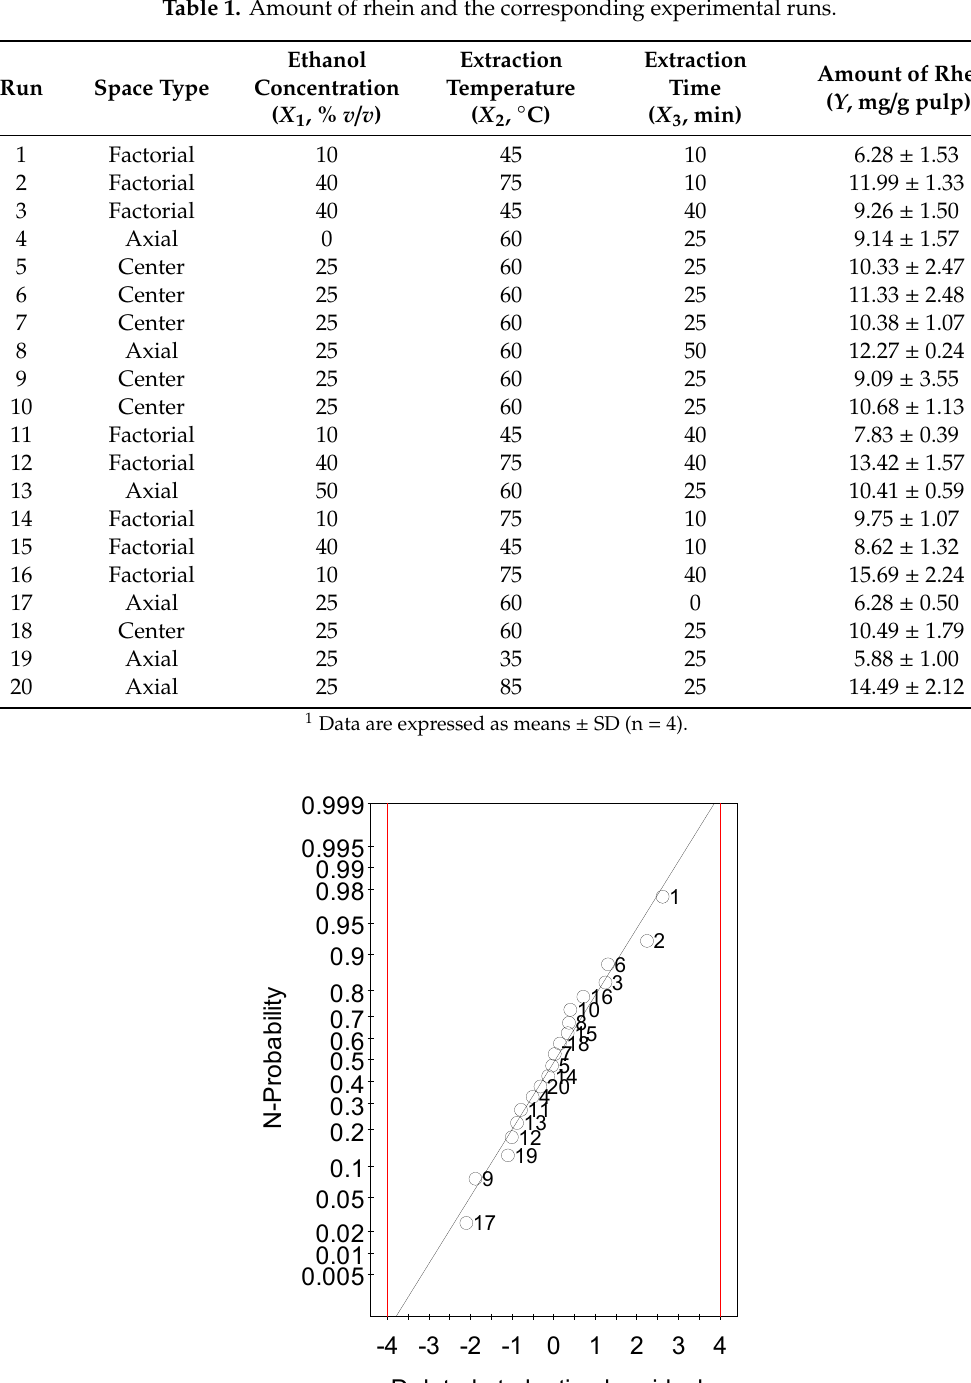
Table 1. Amount of rhein and the corresponding experimental runs.